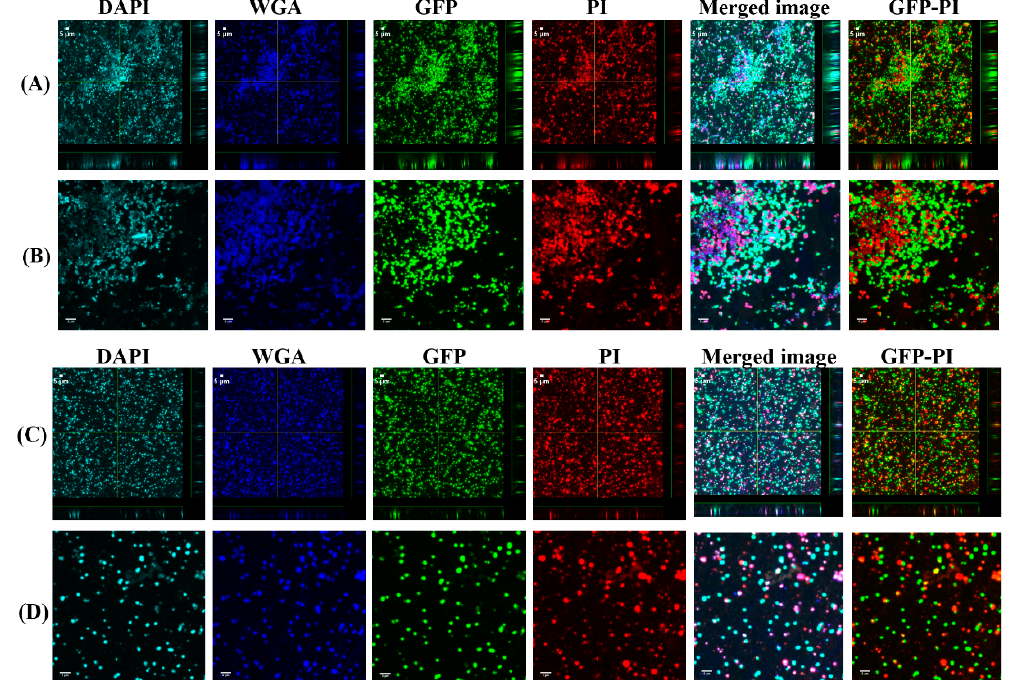
Figure 5. Confocal images of aggregated ( A , B ) and single cells ( C , D ) biofilms for 10 8 CFU/mL after 3 h antibiotic treatment. Panel B and D are zoomed images. Biofilms stained with DAPI for eDNA, WGA stain for PNAG or SF-derived HA, and PI for staining dead cells. Merged images denote the combination of DAPI, WGA, GFP, and PI images. GFP-PI is combination of GFP and PI images.